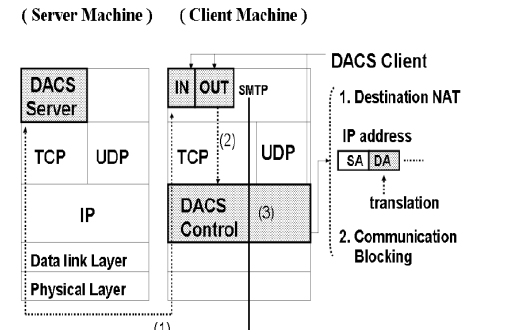
Figure5 Layer Setting of the DACS